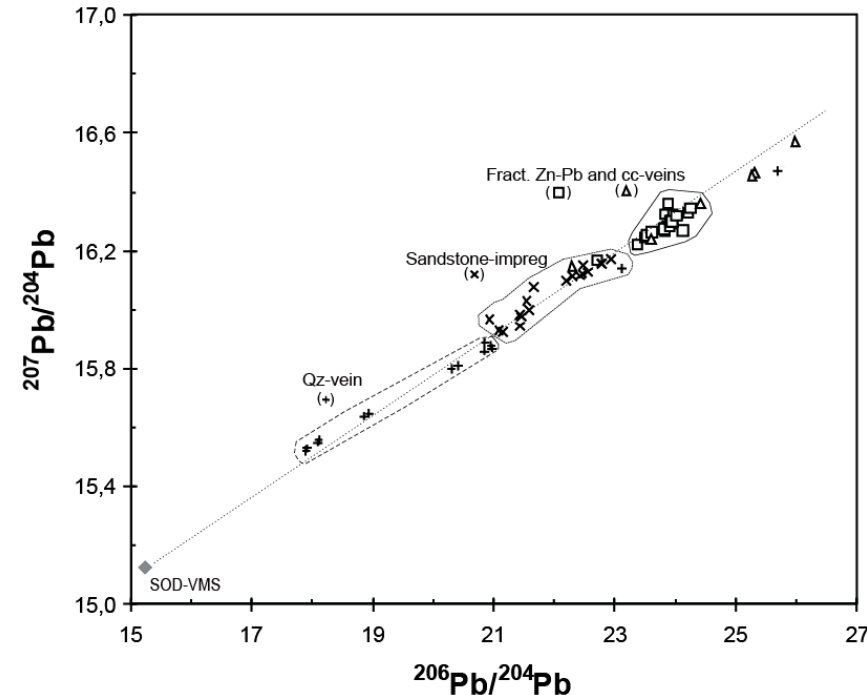
Figure 15. Pb isotope diagram illustrating uniform galena and sphalerite data from fracture-controlled mineralisation types. The data plot on a linear trend defined by clusters of galena from different types of Zn-Pb occurrences. Data sources for different Zn-Pb mineralisation types: fracture-controlled (  = this study), quartz vein-type (+ = [28]), calcite vein-type (  = [28]), sandstone impregnation-type (X = [26]). Also added is a field for VMS ores in the Skellefte Ore District (SOD-VMS = [29]), which may approximate the basement lead existing at ca 1.9 Ga, and a reference line which connects the VMS-type of lead with other